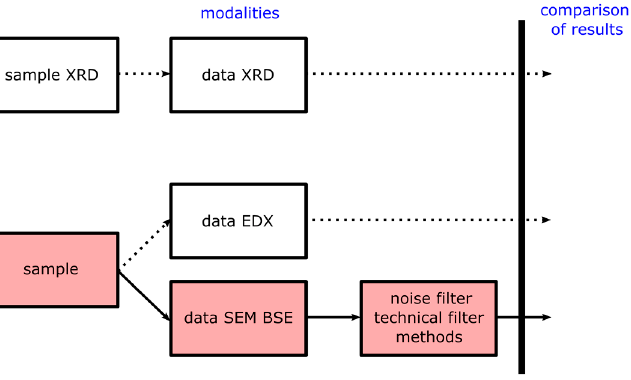
Figure 1. Relationship of the presented approach, SEM BSE, to the other modalities, EDX and XRD.